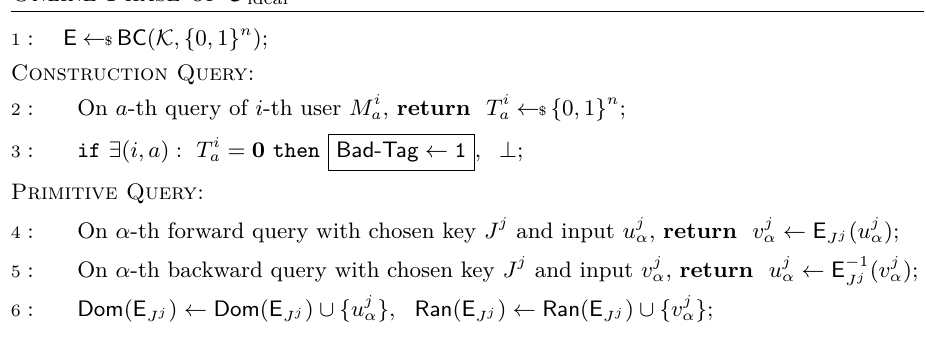
Figure 4.1: Online Phase of the Ideal oracle $: Boxed statements denote bad events. Whenever a bad event is set to 1 , the ideal oracle immediately aborts (denoted as ⊥ ) and returns the remaining values of the transcript in an arbitrary manner. So, if the game aborts for some bad event, then its previous bad events must not have